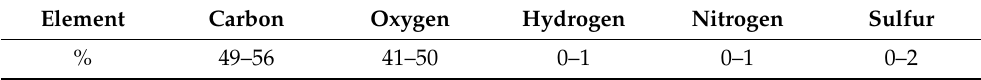
Table 1. Elemental analysis of GO